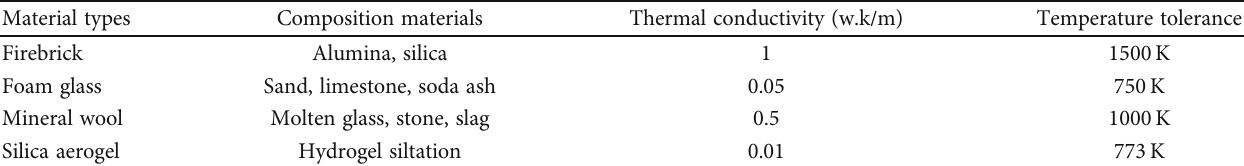
Table 1: Insulation materials employed for strati fi ed